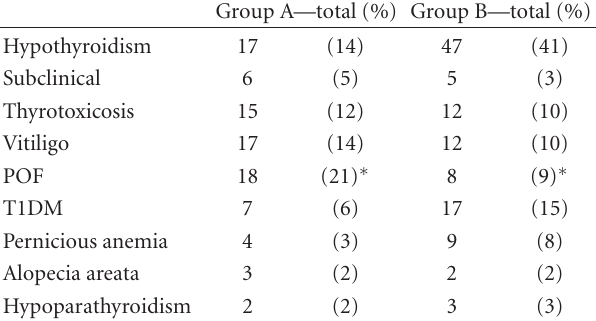
Table 2: Autoimmune diseases coexisting with Addison’s disease in the group A and group B (including only the patients with probable autoimmune